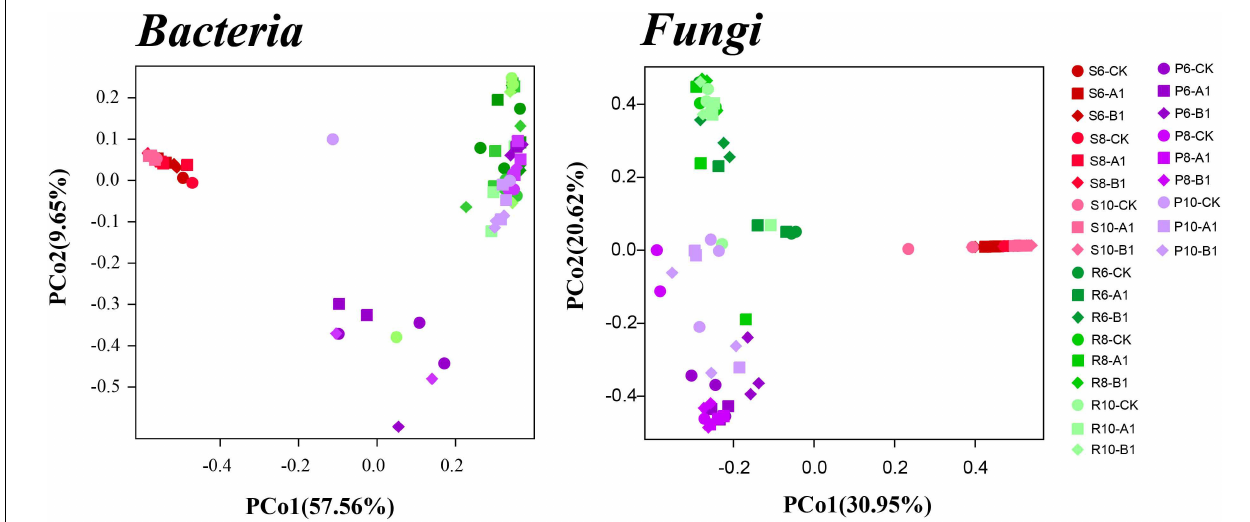
FIGURE 3 | Results of a PCoA analysis of both the bacterial and fungal communities across the three habitat classifications (soil, roots, and stems), seasons (June, August, and October), and genotypes (CK, A1, and B1). Based on multivariate ANOVA results, habitat and season had greater impacts on bacterial and fungal community composition than did genotype ( Supplementary Table 3